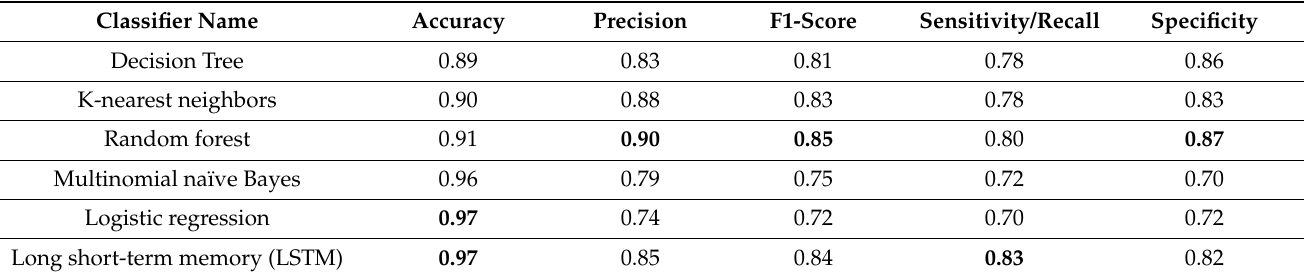
Figure 4. Result summary of all classification models on the Google Jigsaw dataset. Table 5. LSTM model on the Google Jigsaw dataset.